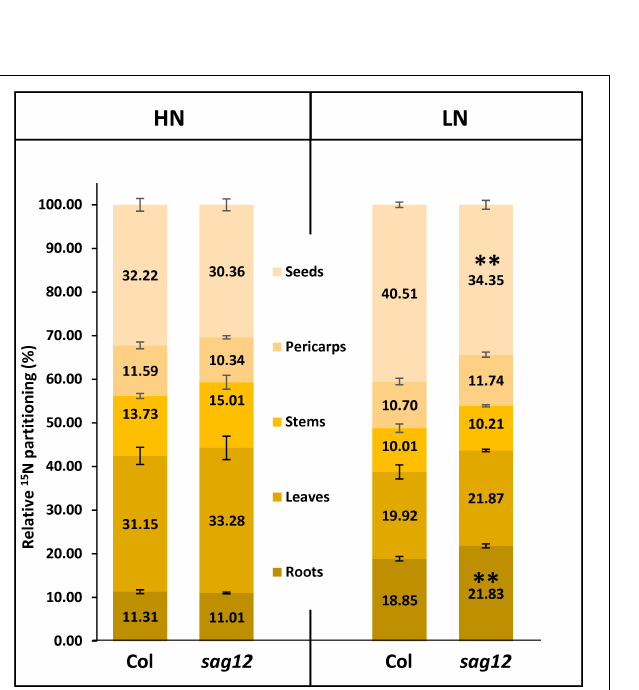
FIGURE 3 | N allocation in roots and seeds is affected in sag12 under LN conditions. Partitioning of 15 N in the different plant compartments (roots, leaves, stems, pericarps, and seeds) was calculated from data obtained from plants harvested at seed maturity (125 DAS). Results are presented as means ± SE ( n = 4). Significant differences between Col and sag12 are indicated by ( ∗∗ p ≤ 0.01; n =